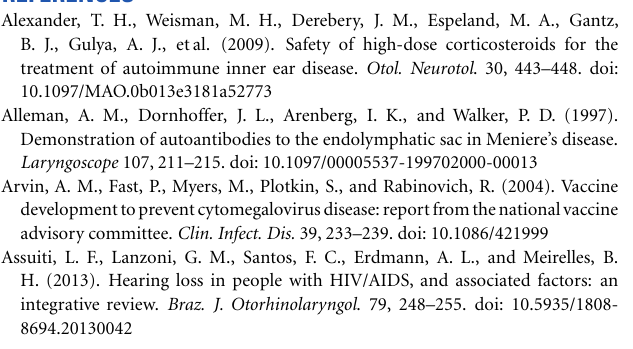
cytokines, and cell adhesion molecules. An alternative approach is to facilitate phagocytosis of loaded delivery vehicles by